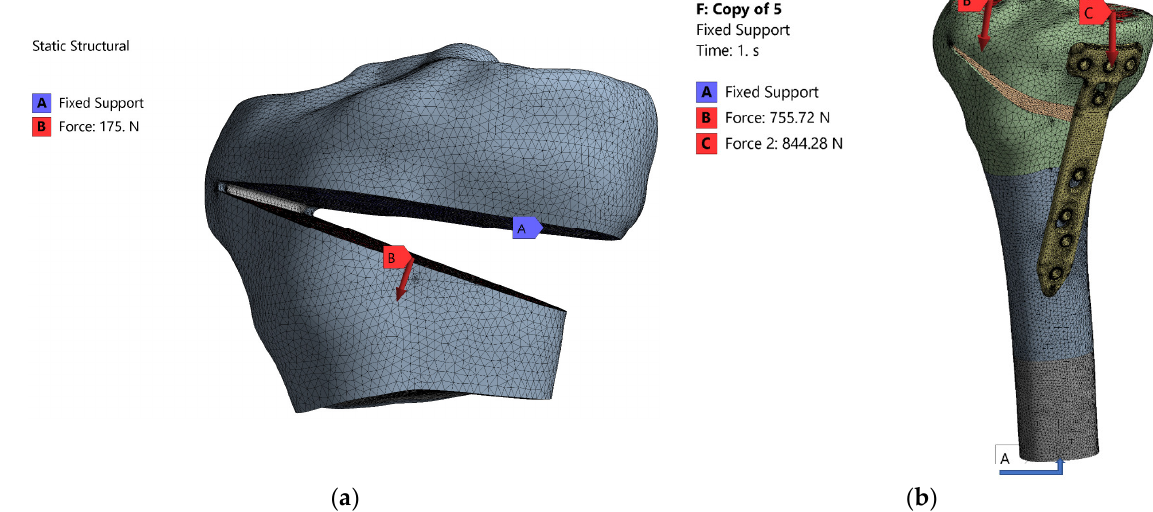
Figure 8. Meshing the models ( a ) and application of stresses and constraints ( b ).